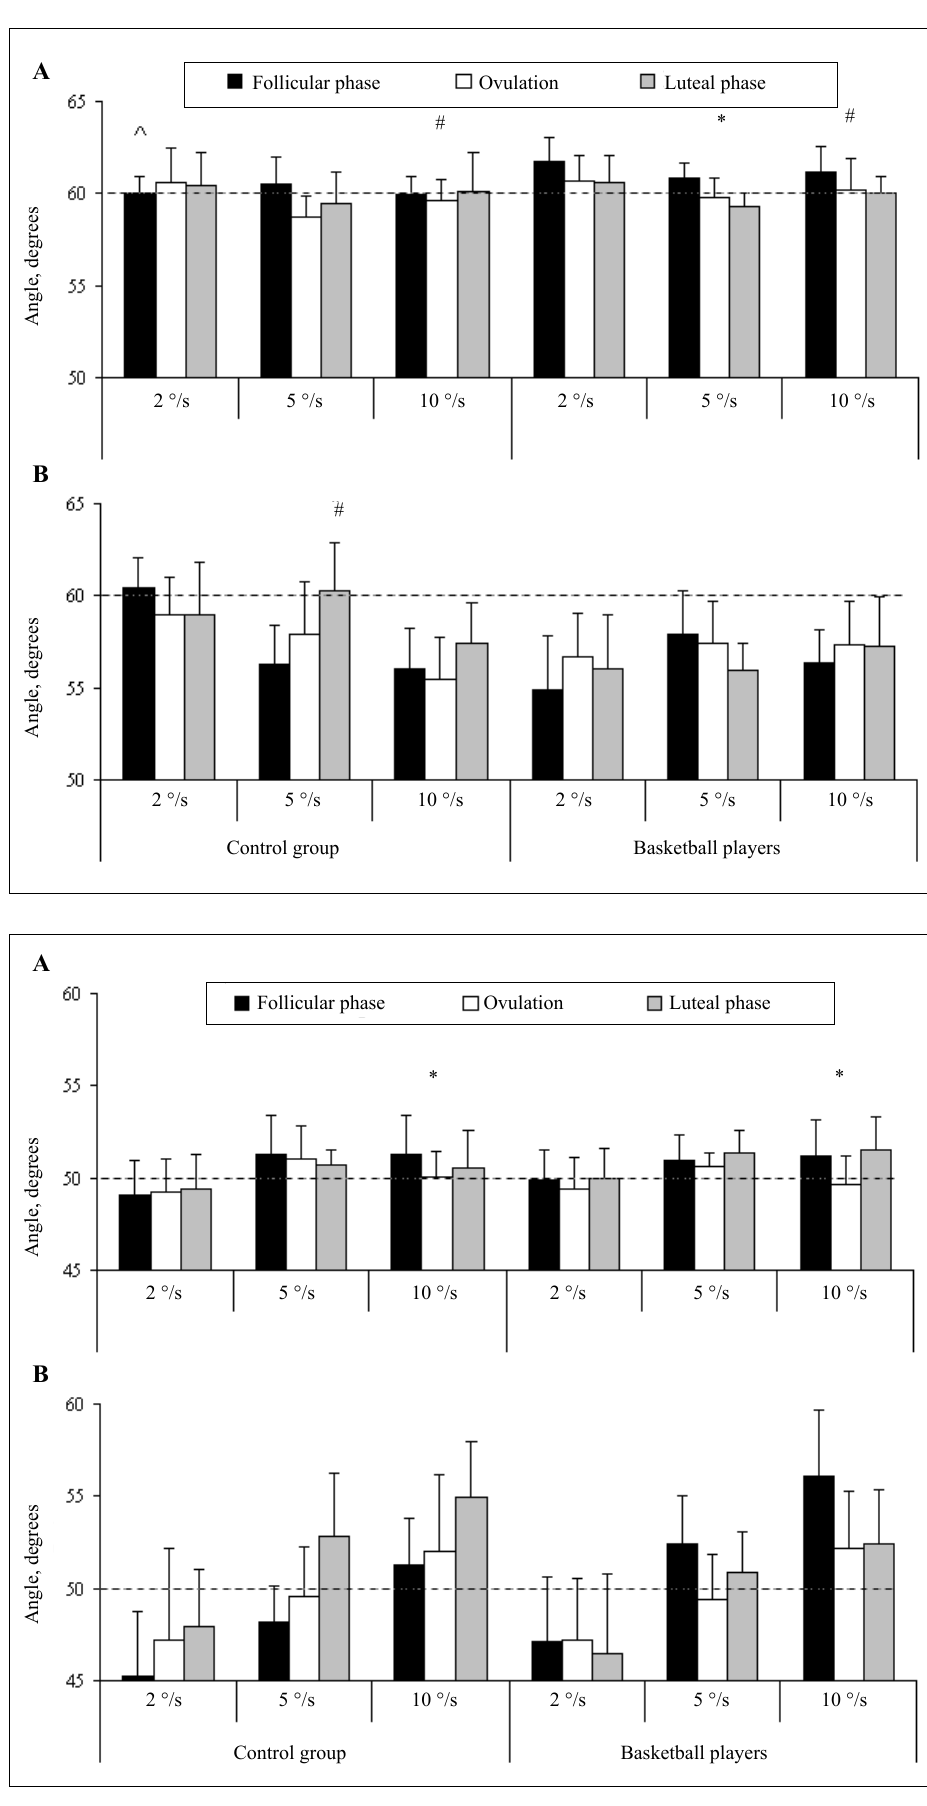
Figure 5. Knee joint position sense for control group and basketball players with extended knee with open (A) and closed (B) eyes during the menstrual cycle